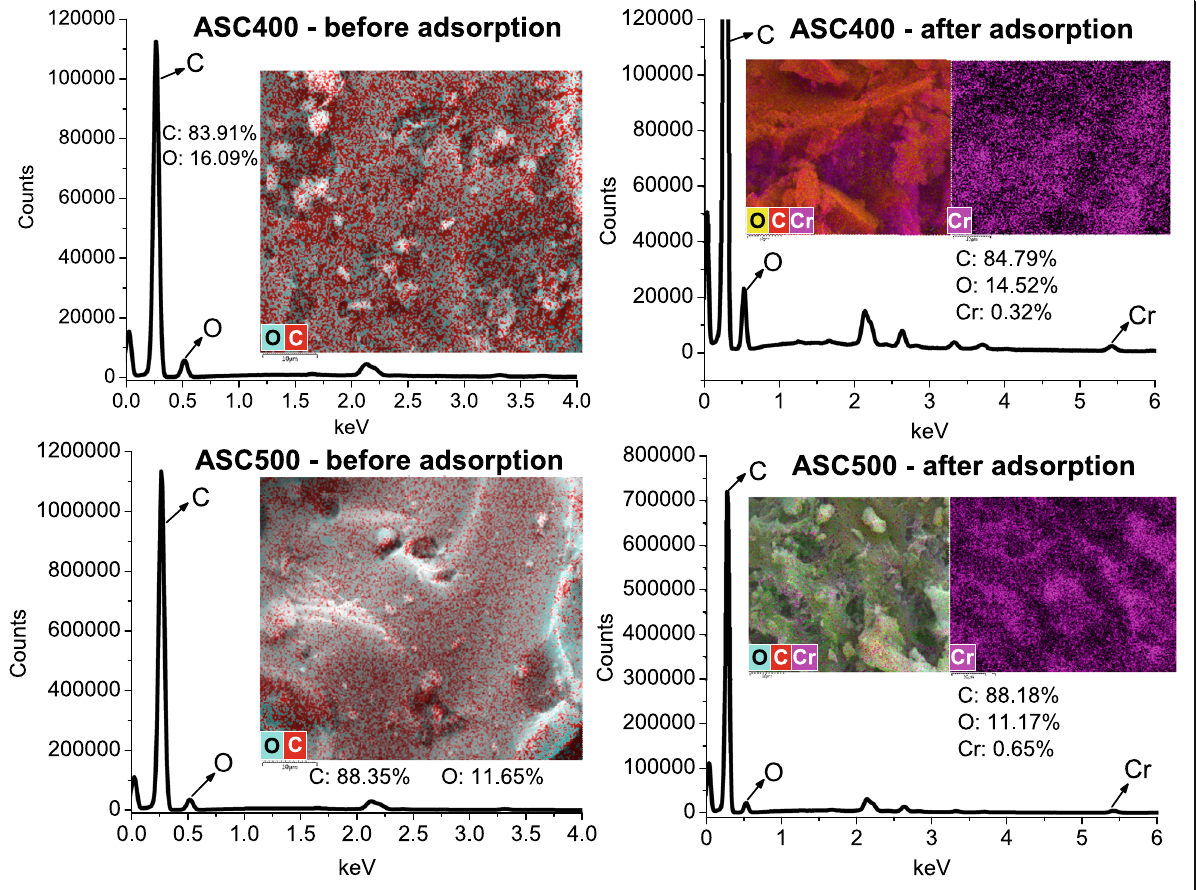
Fig. 5 EDX spectra and elemental mapping images of ASC400 and ASC500 before and after Cr(VI)